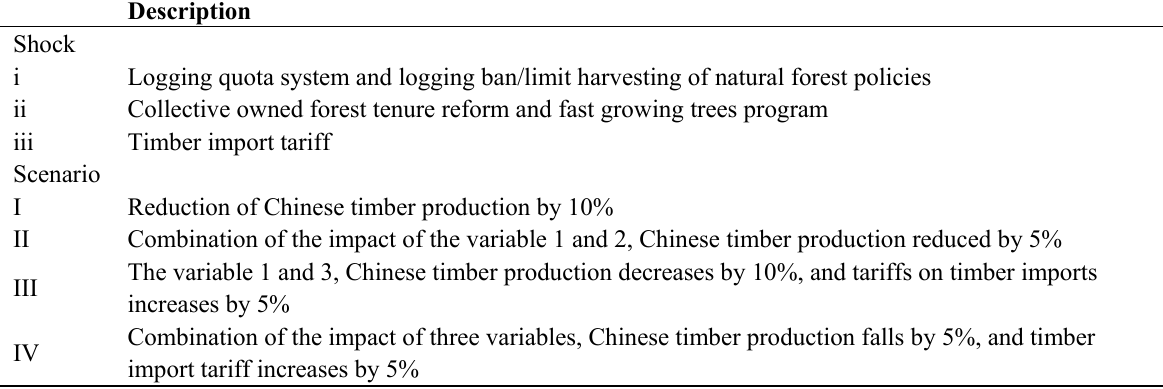
Table 3. Shock variables and Simulation scenarios.